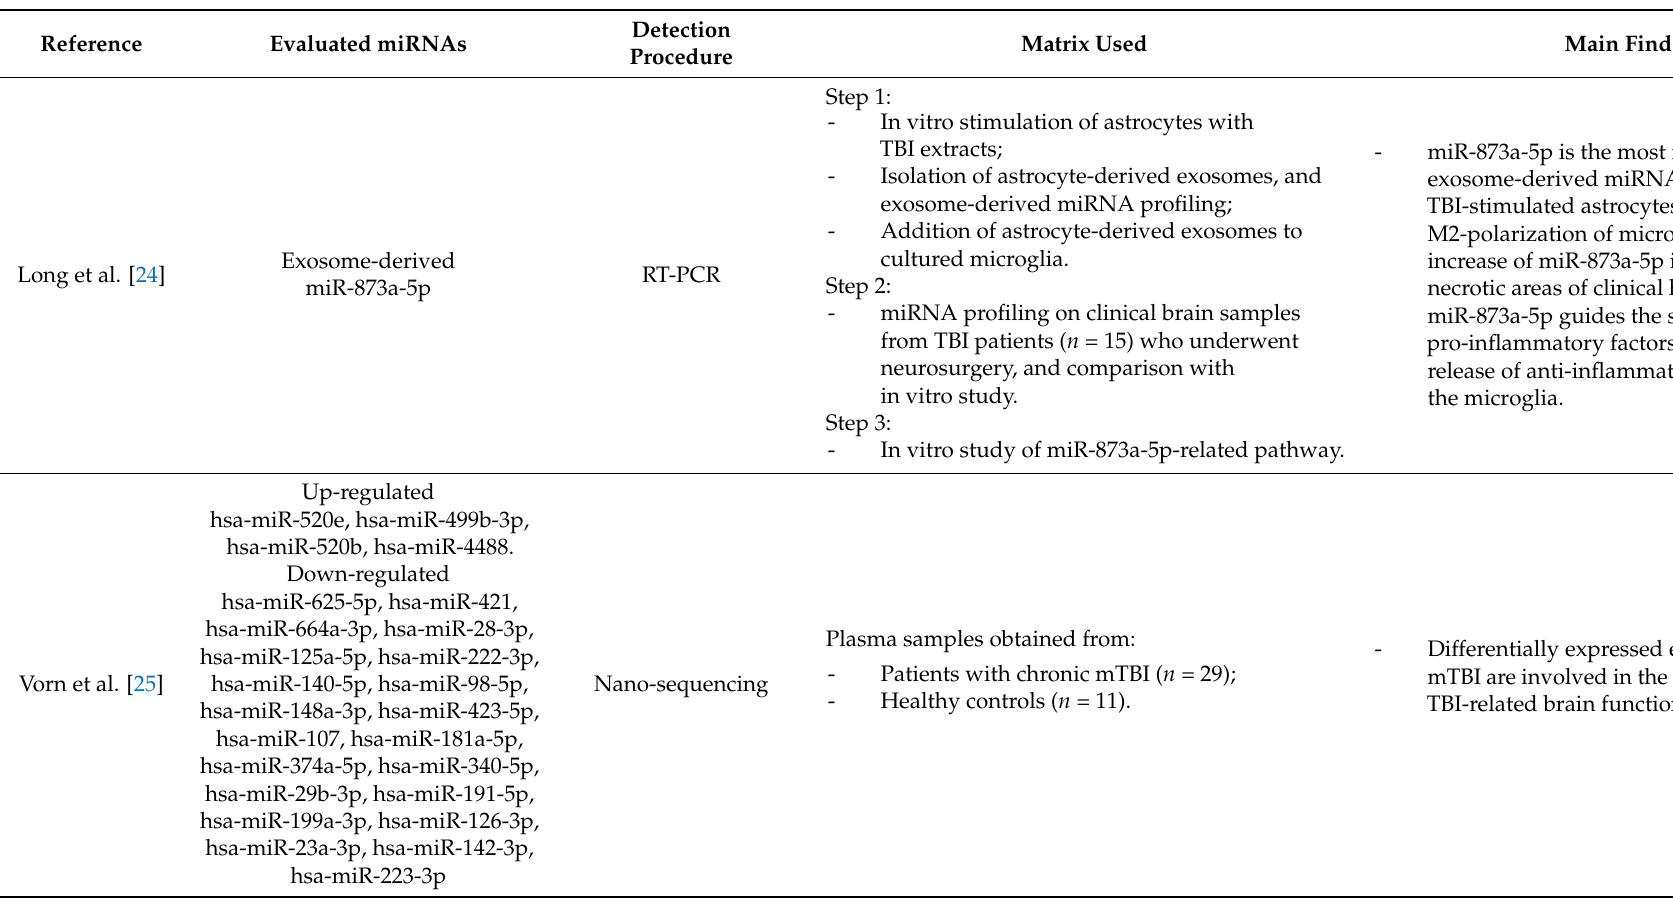
Table 1. Main findings of the selected studies involving the role of miRNAs in TBI diagnosis (CSF = cerebrospinal fluid; mTBI = mild traumatic brain